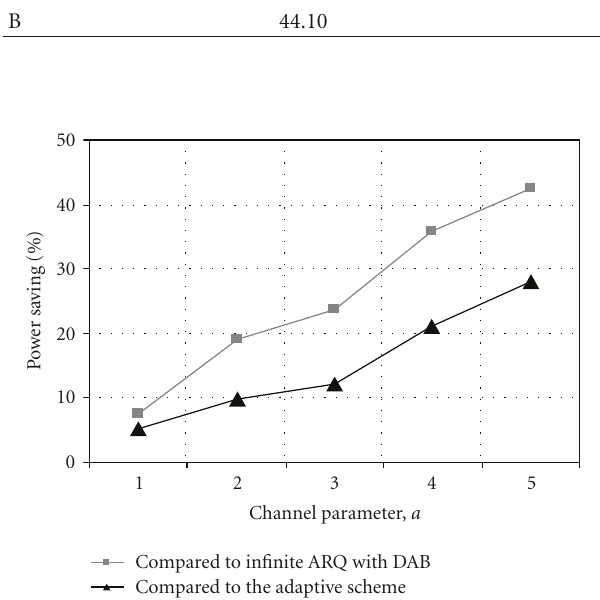
Figure 16: Contribution of I-, P-, and B-frame packet losses to total packet loss in the FLC with DAB and power-aware scheme.